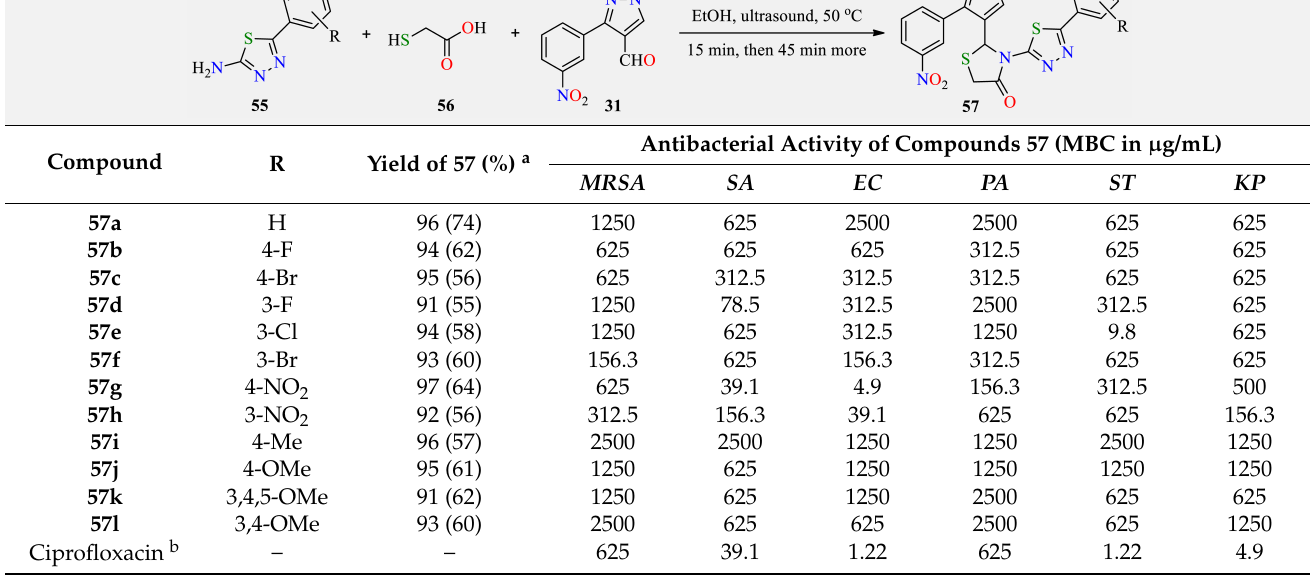
Table 15. Three-component synthesis of thiadiazole-1 H -pyrazol-4-yl-thiazolidin-4-ones 57 and their in vitro antibacterial activity (MBC) against six bacterial